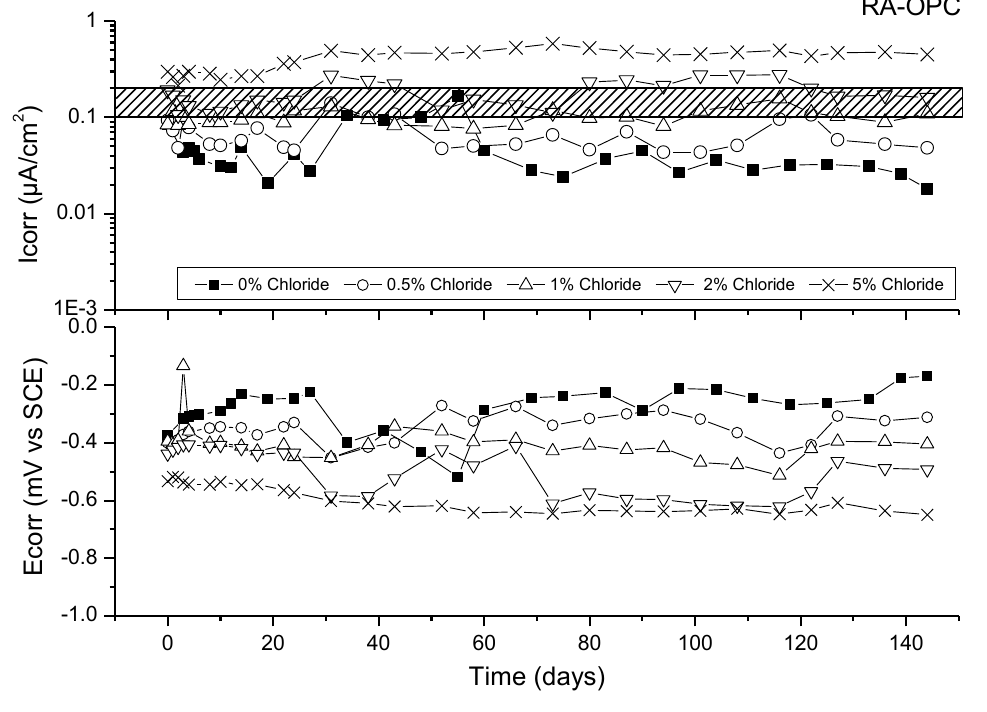
Figure 7. Corrosion rate and corrosion potential of steel reinforcement embedded in RA-OPC specimens and different chloride